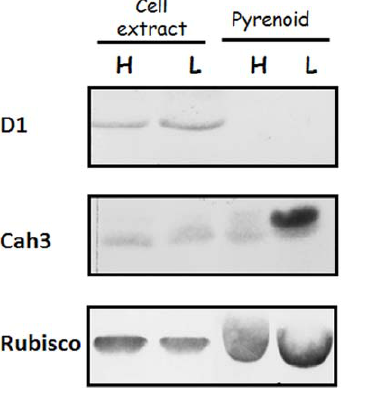
Figure 6. Immunoblot analysis of total cell extracts and isolated pyrenoid fractions from high- (H) and low-CO 2 -grown (L) Chlamydomonas cells probed with antibodies against D1 protein of PSII, Cah3 and Rubisco large subunit. All lanes were loaded with 10 m g protein. doi:10.1371/journal.pone.0049063.g006 PLOS ONE |